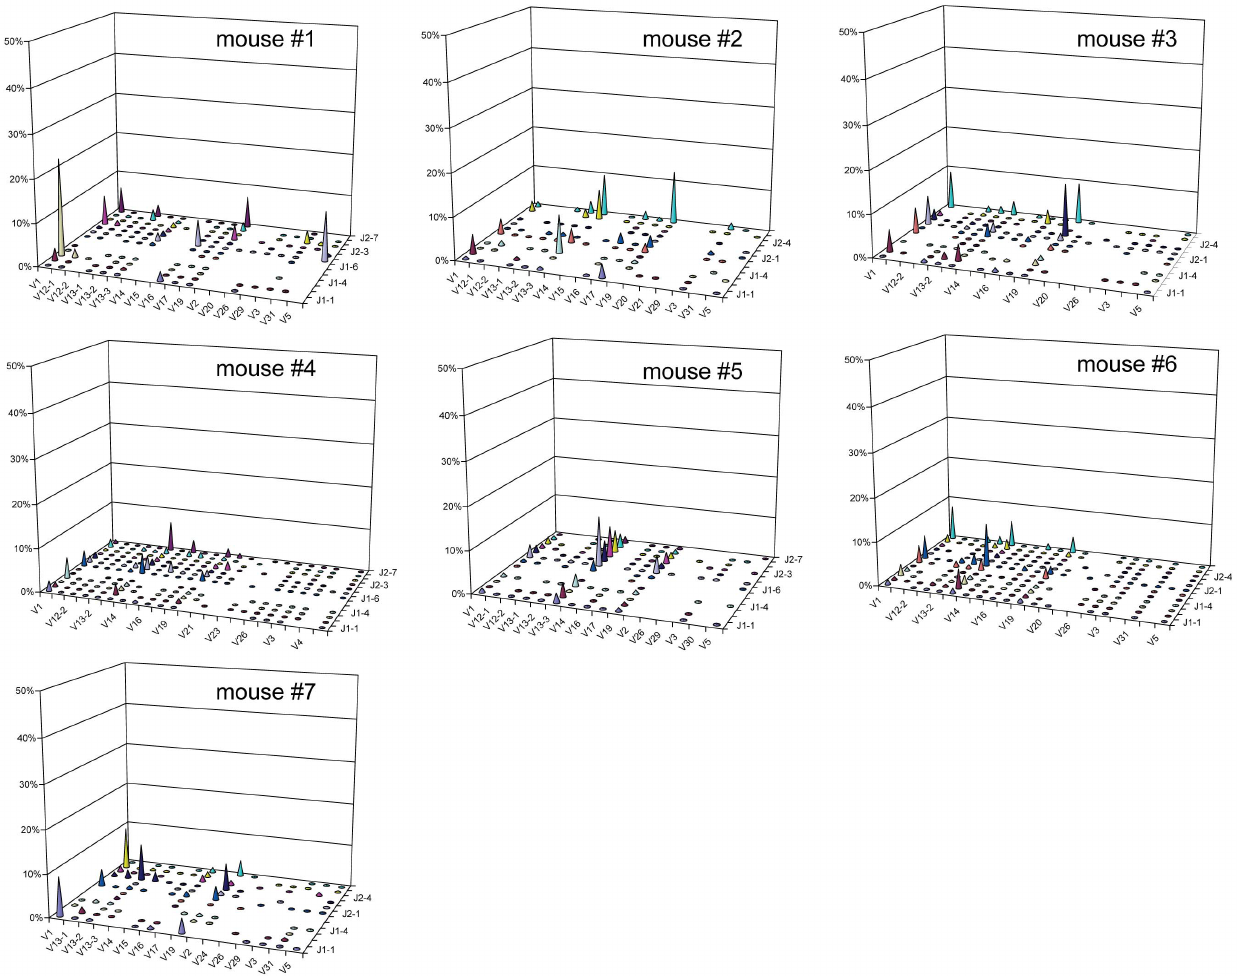
Figure 7. Absence of monoclonal expansions in prediabetic mice. The frequencies of V and J gene segment usage within total CDR3 b sequences amplified from islet-infiltrating CD4 + CD44 high cells isolated from individual prediabetic (B) mice. Each panel represents one